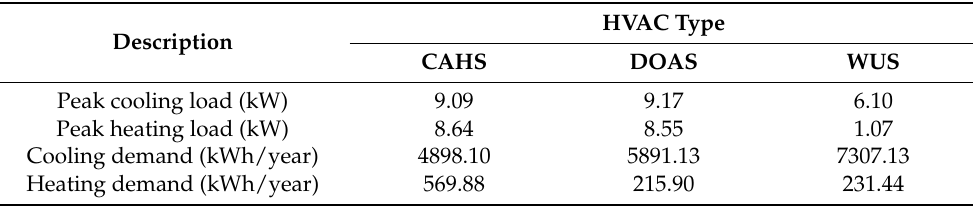
Table 3. Simulated annual thermal demands (cooling and heating) and peak cooling and heating loads of a highly occupied indoor space served by three types of HVAC system (Figure